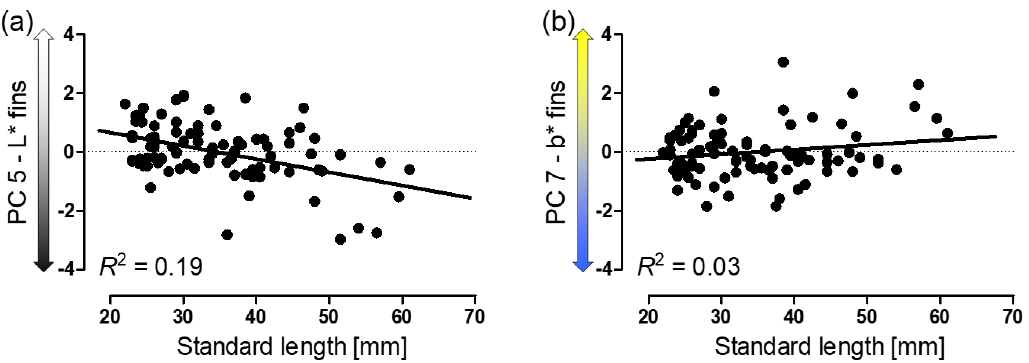
Figure 5. Scatterplots showing the relationships between male body size and ( a ) residual fin lightness (PC 5) and ( b ) residual yellow coloration of the fins (PC 7). Linear regressions and R 2 -values are shown to better illustrate the trends.